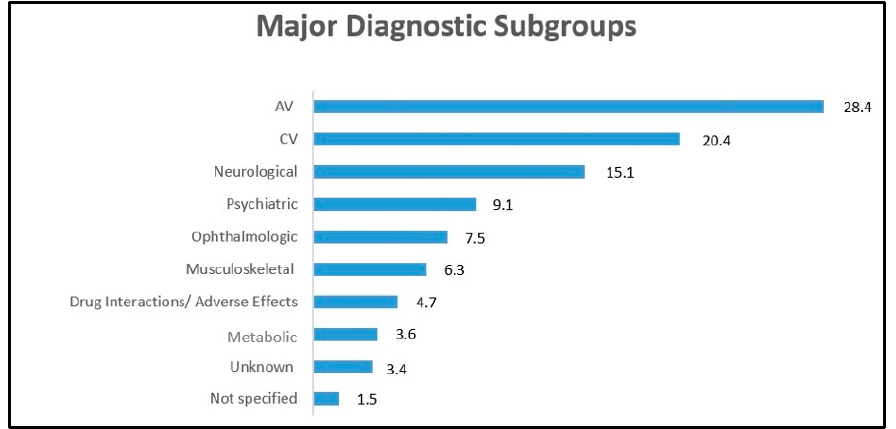
Figure 2. Different etiologies of vertigo. AV = audio-vestibular, CV = cardiovascular. Numbers are expressed in percentages.